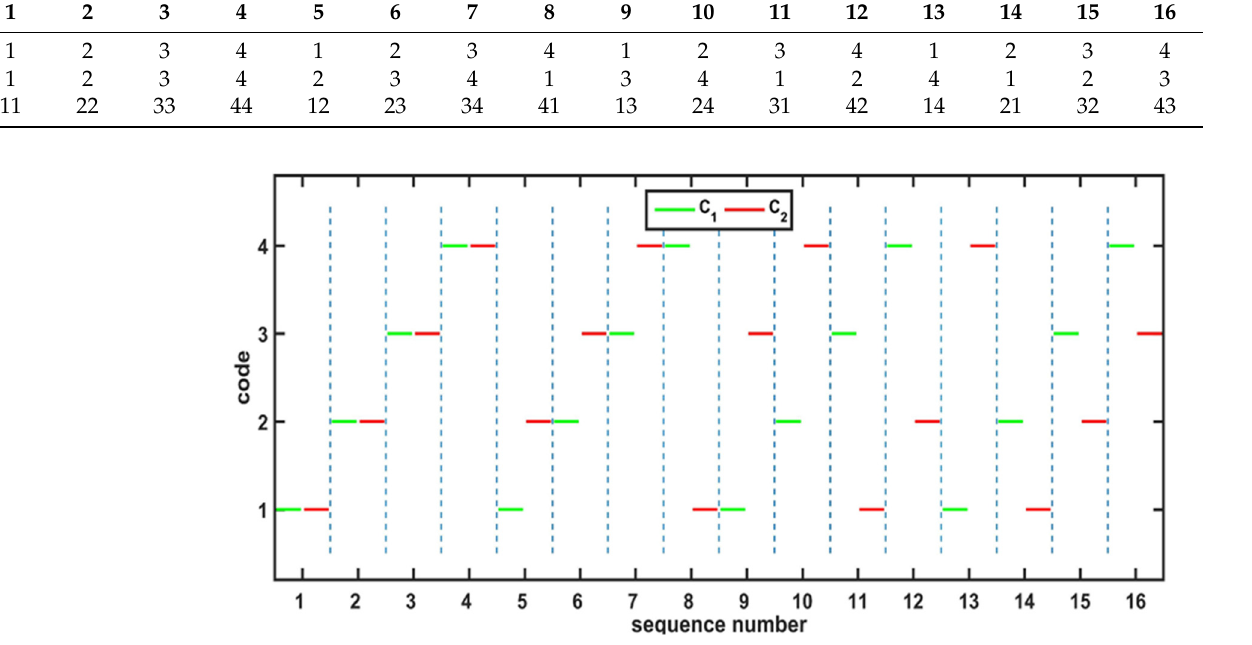
Figure 2. Patterns used in the proposed method. ( a )Three sinusoidal patterns. ( b ) The coded pat- tern.